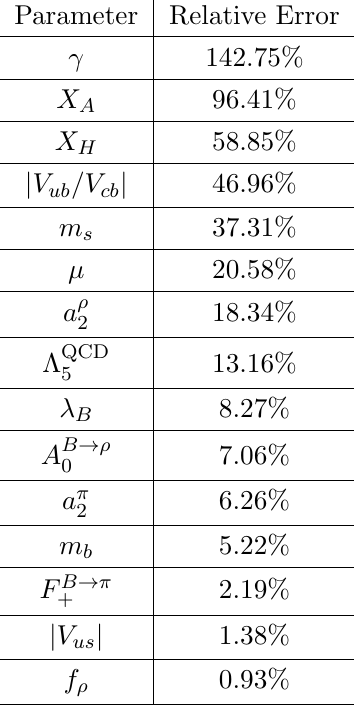
is the form factor for 0